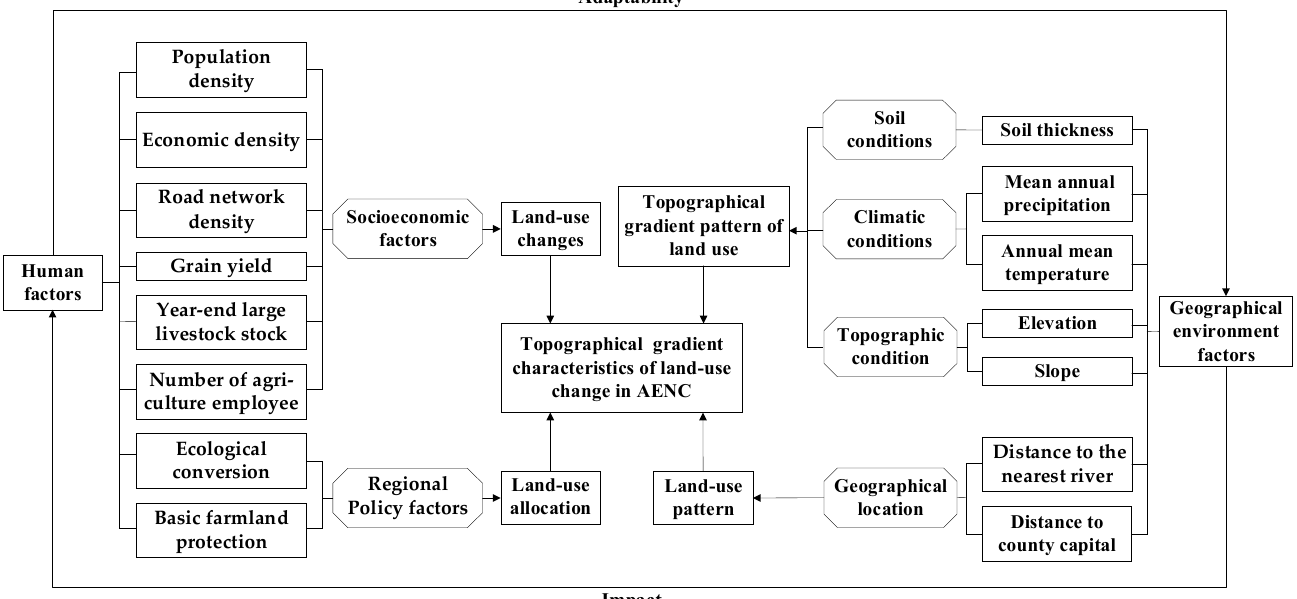
Figure 6. Driving mechanism of topographical gradient effect of land-use change in the AENC.